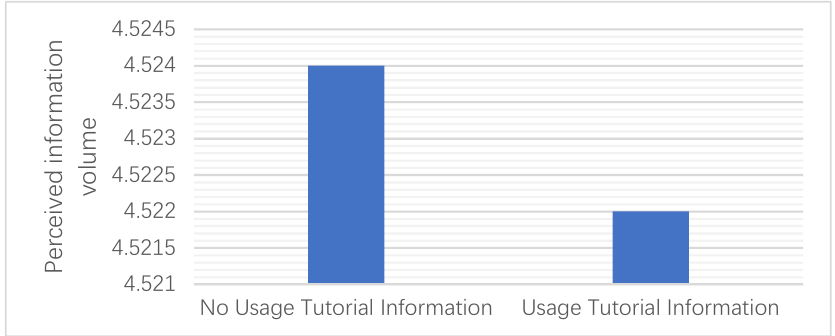
Figure 9. The influence of using the product’s tutorial information on consumers’ perceived information volume.